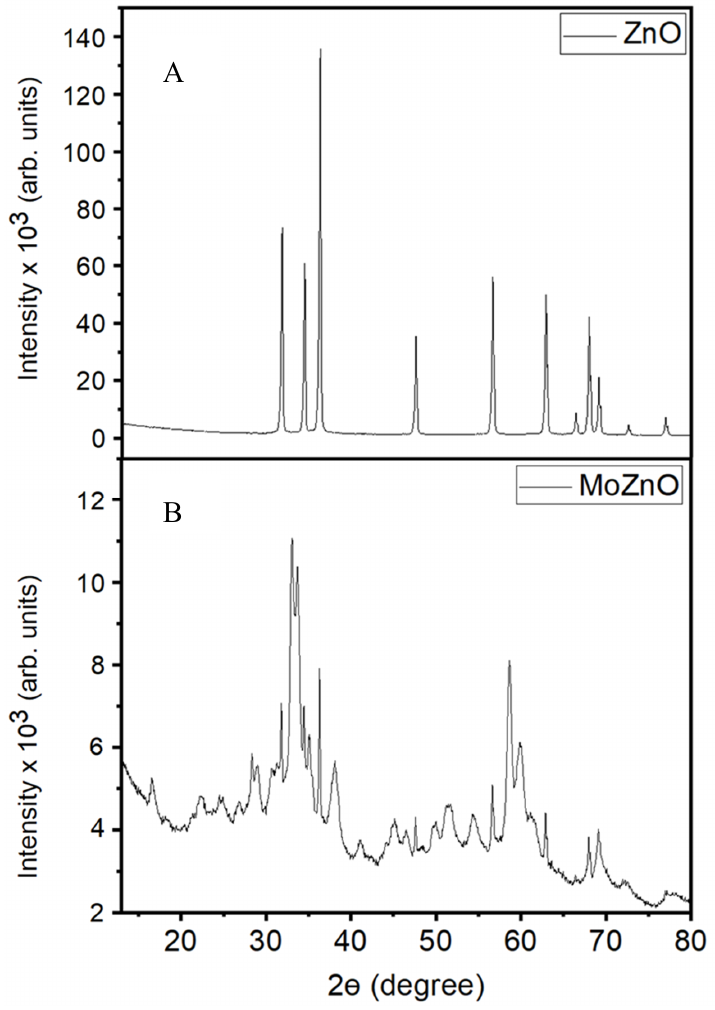
Figure 3. X-ray di ff raction patterns of the ( A ) ZnO and ( B ) Figure 3. X-ray diffraction patterns of the ( A ) ZnO and ( B ) MoZnO. Table 2. Calculated crystallite size, lattice constants, and microstrain values of ZnO and MoZnO.